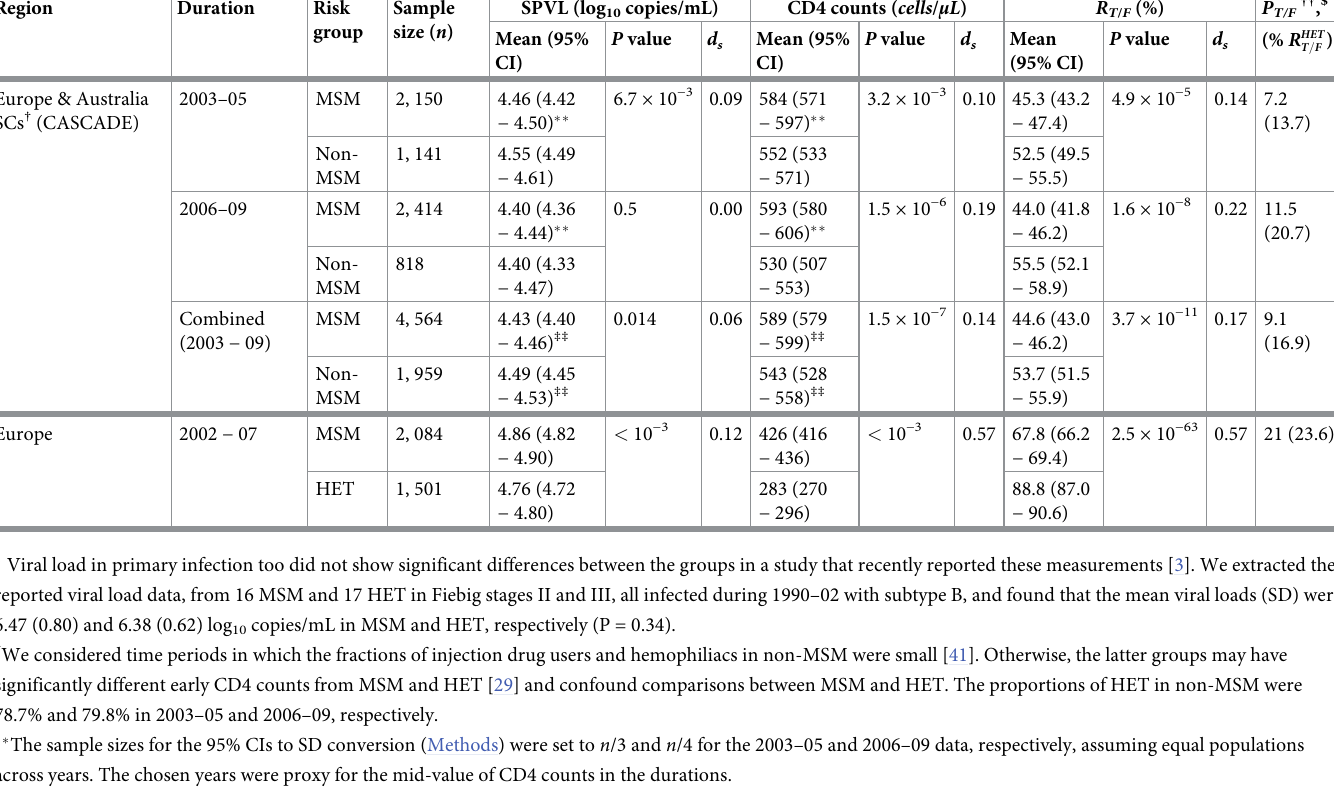
Table 2. Set-point viral load and relative per parasite pathogenicity of T/F strains in HET and MSM. SPVL � , early CD4 cell counts, the corresponding R T / F in infected adults at seroconversion (from the CASCADE study [41]) or diagnosis (from the Europe study [19]). For the CASCADE data, the mean and SD were calculated from the median and 95% CIs (see Methods) obtained by digitizing using WebPlotDigitizer. The 95% CIs provided here are following the normal approximation. Information for the European study is in Table 1. Region